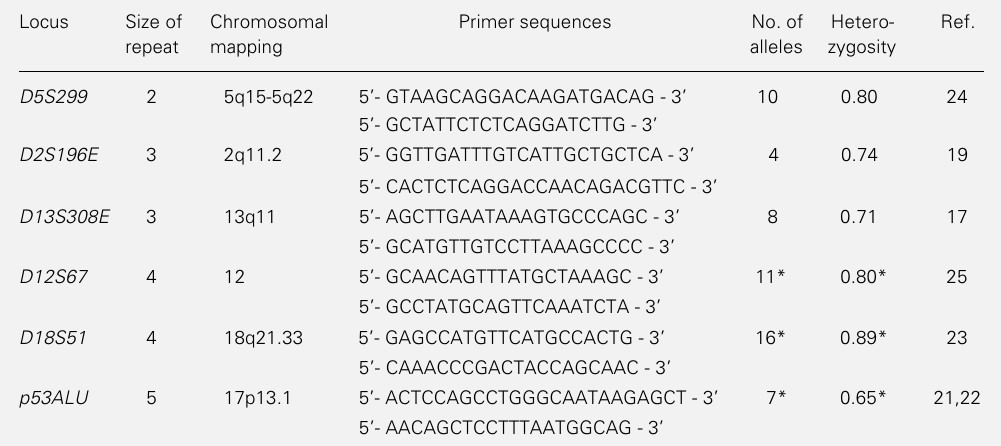
Table 1 - Details of the microsatellites studied and some of their population